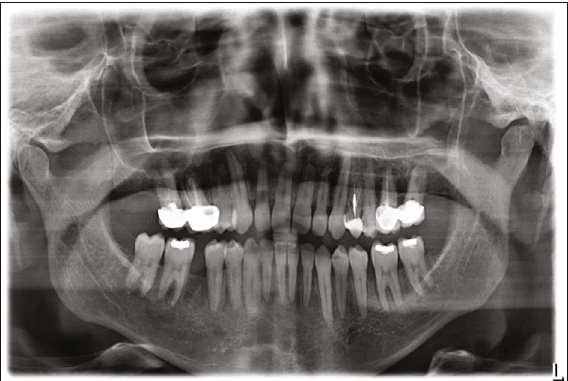
Figure 1: Pretreatment panoramic radiograph of initial patient presentation.